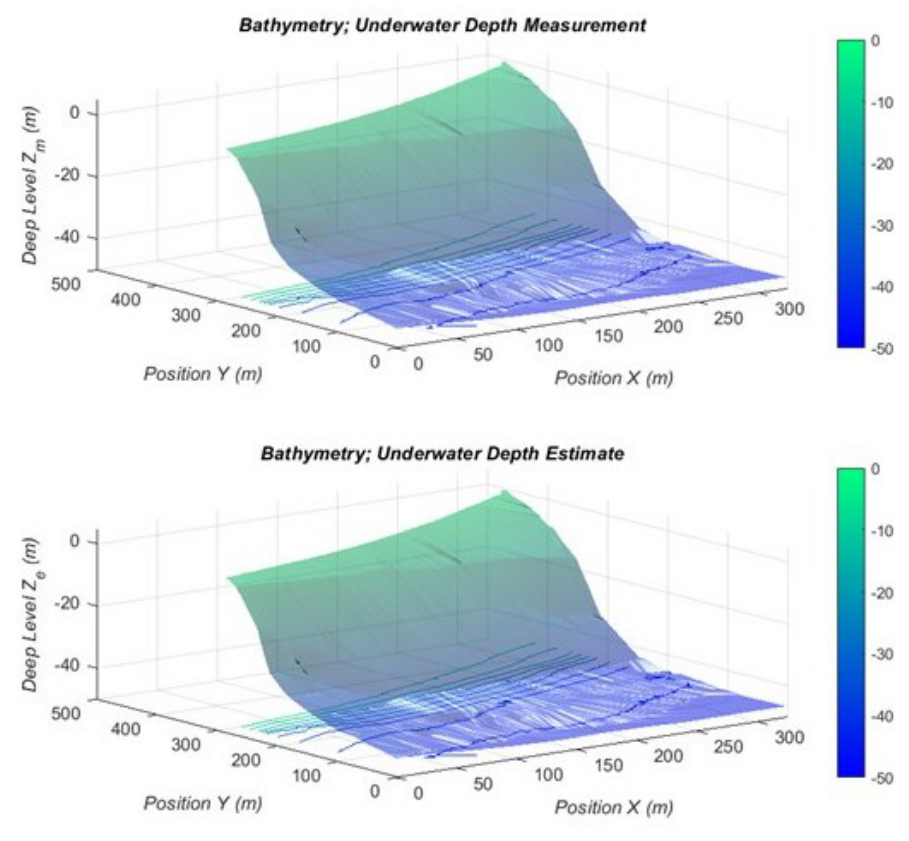
Figure 17. Underwater map with ( top ) measured and ( bottom ) estimated depth levels based on experimental data.